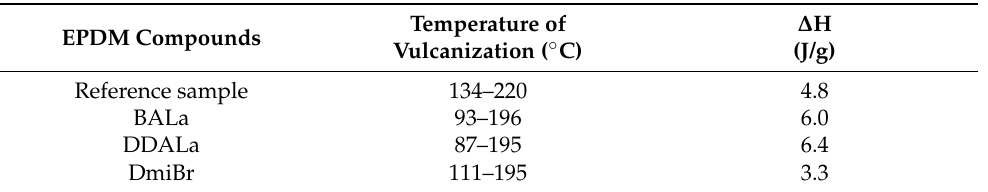
Table 8. Temperature and enthalpy of EPDM vulcanization determined by DSC (standard